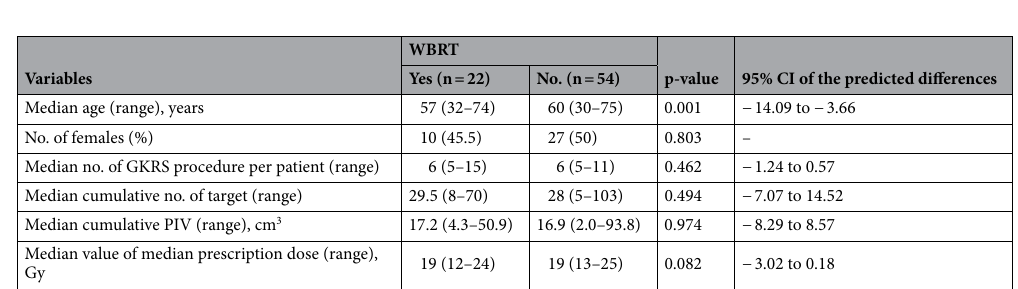
Figure 4. Kaplan–Meier survival curves. ( a ) A survival curve from the diagnosis of NSCLC. The median OS is 65.6 months (95% CI 53.42–77.78 months). ( b ) A survival curve from the first GKRS procedure. The median OS is 52.3 months (95% CI 41.47–63.13 months). ( c ) The median OS from the first GKRS procedure in patients with WBRT and the patients without WBRT is 35.9 months (95% CI 31.09–40.71 months) and 56.0 months (95% CI 42.34–69.66 months), respectively ( p = 0.076). ( d ) The survival curves from the second GKRS in 64 patients without WBRT before the first GKRS. The median OS after the second GKRS in the 10 patients with salvage WBRT and the 54 patients without salvage WBRT was 27.0 months (95% CI 2.83–51.17) and 42.9 months (95% CI 28.97–56.83), respectively (p = 0.32). *The median OS is marked using a black dotted line in each figure. OS overall survival, NSCLC non-small cell lung cancer, GKRS gamma knife radiosurgery, WBRT whole-brain radiotherapy.